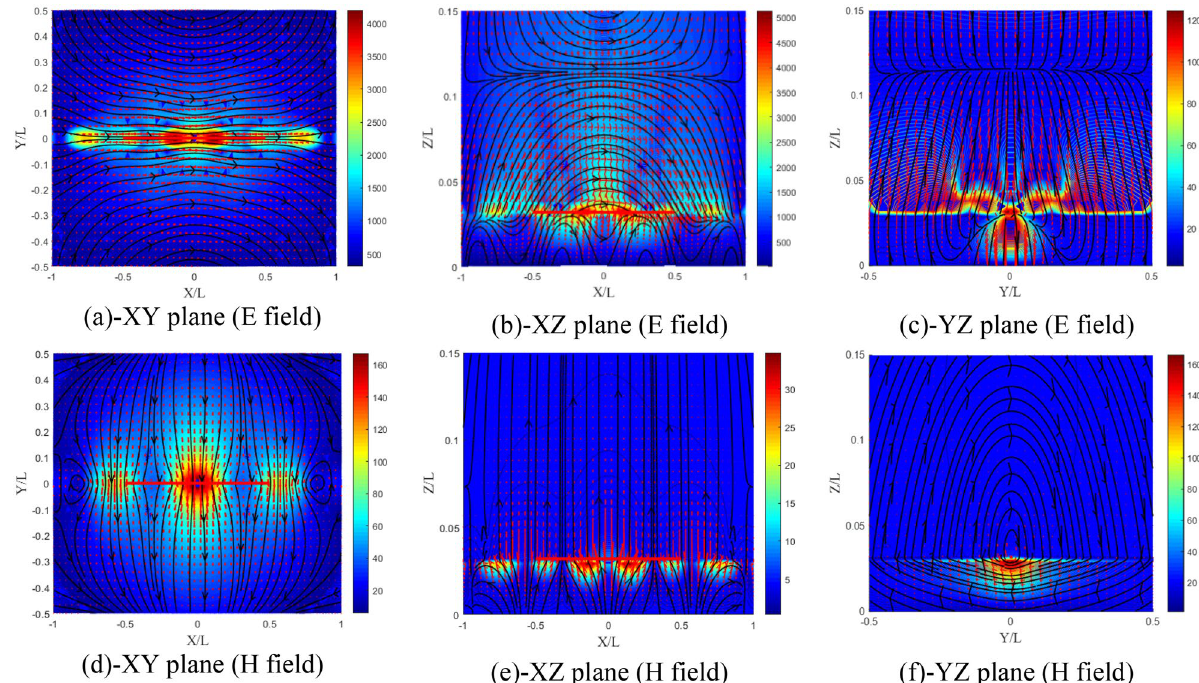
η xy ) case, ( a – c ) electric and ( d – f ) = −